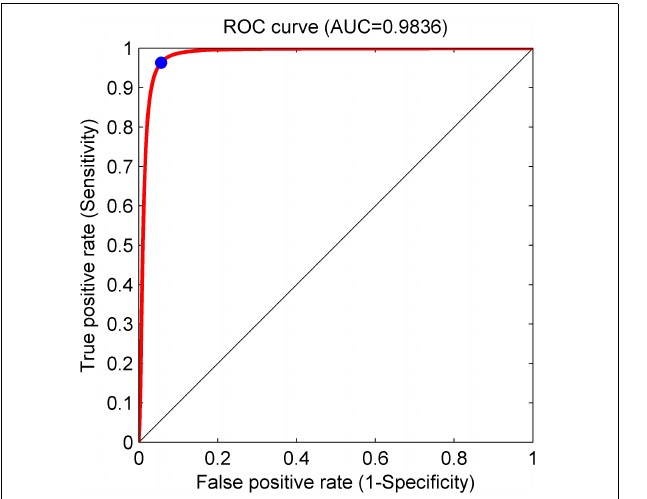
FIGURE 9 | Receiver operating characteristic (ROC) curve with the optimal area under the curve (AUC) of 0.9836 using an 8-layer convolutional neural network (CNN) model. The blue dot represents better performance at the balance of the false positive rate and true positive rate.